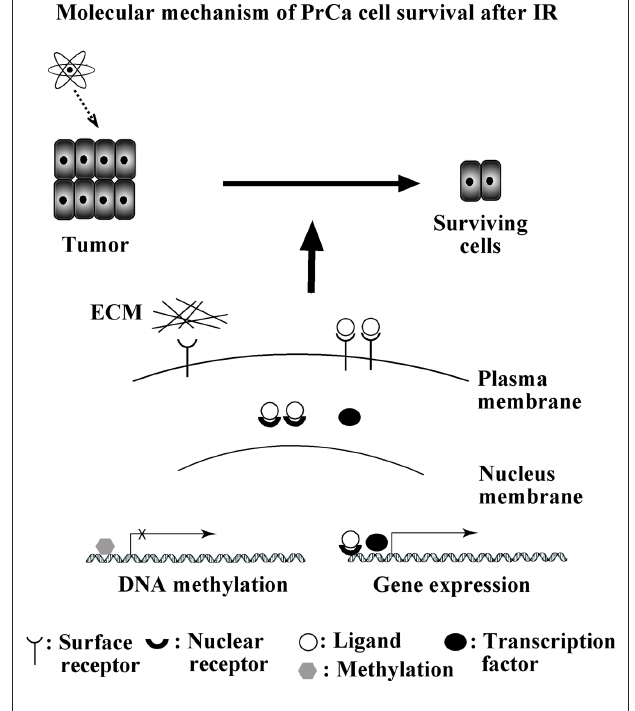
FiguRE 1 | Summary of molecular mechanisms underlying radioresistance of PrCa. During RT, some cells survive after radiation. These cells play an important role in recurrence of prostate caner. Molecules discussed in this review were